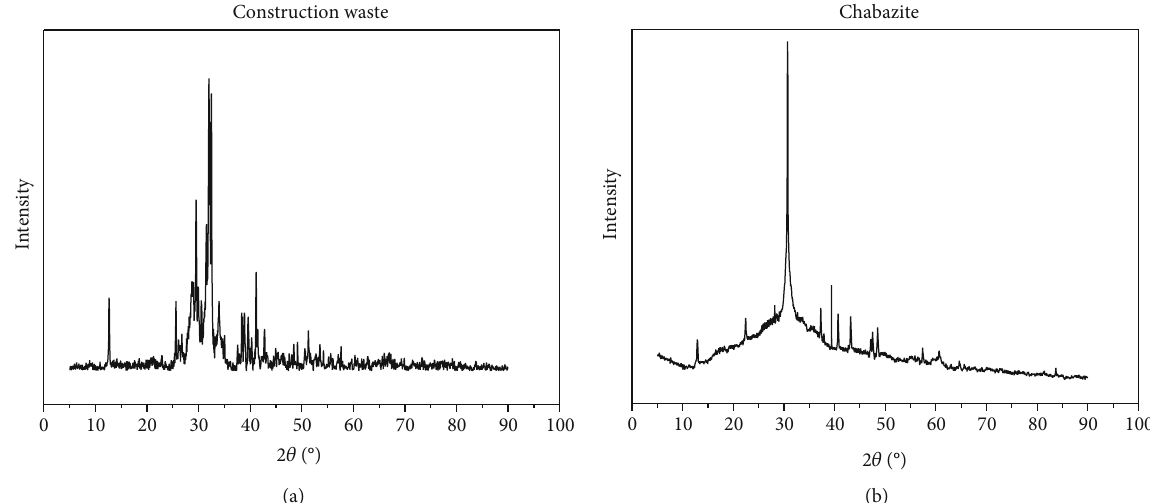
Figure 2: XRD patterns of construction waste and synthesized chabazite.